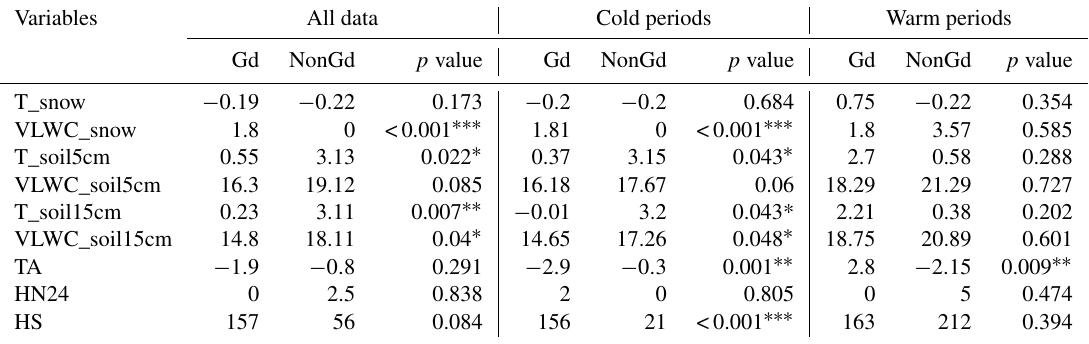
Table 2. Pista Nera: summary statistics showing median values of various variables for gliding days (Gd) and non-gliding days (NonGd). For each variable, distributions were contrasted (Mann–Whitney U test), and the level of significance p is given. Temperatures are in degrees Celsius, VLWC is in percent and snow height is in centimetres.